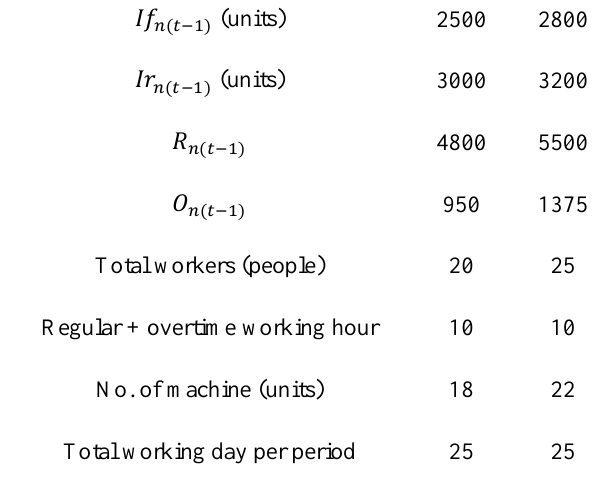
Table 3. Initial data for two